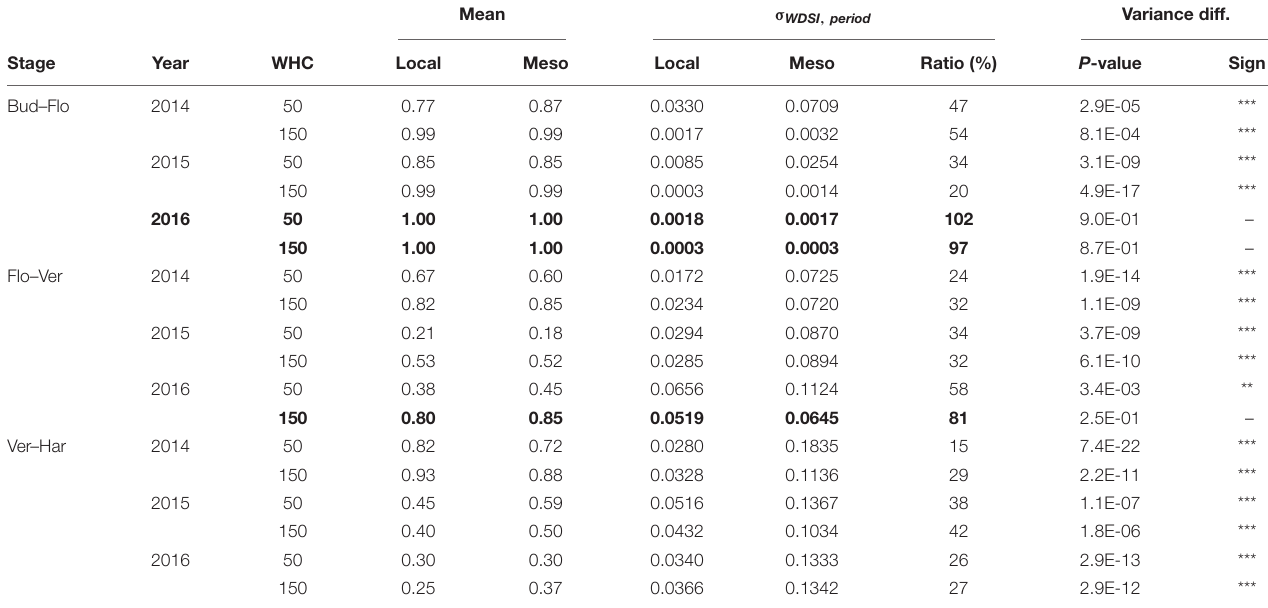
TABLE 2 | Average (mean) and standard deviations ( σ WDSI , period ) of mean WDSI during three development periods of grapevine, in 2014, 2015, and 2016. Mean σ WDSI , period Variance